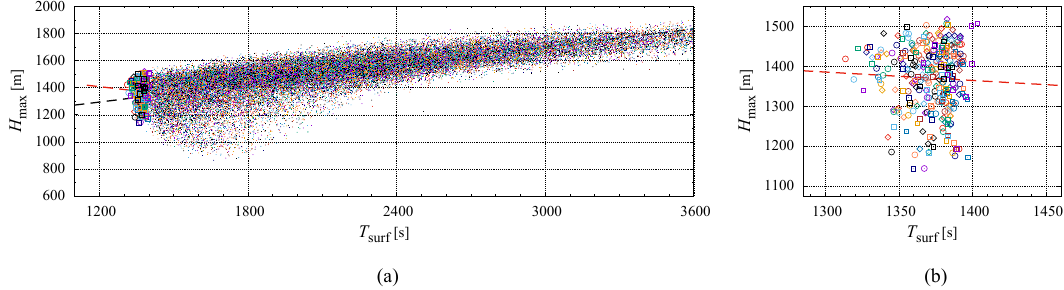
Figure 8. Maximum attained height of the mother particle for surface raindrops against surface precipitation time, T surf . The circled points represent the first 10 raindrops. Only the plots for the first 10 raindrops are drawn in (b) .